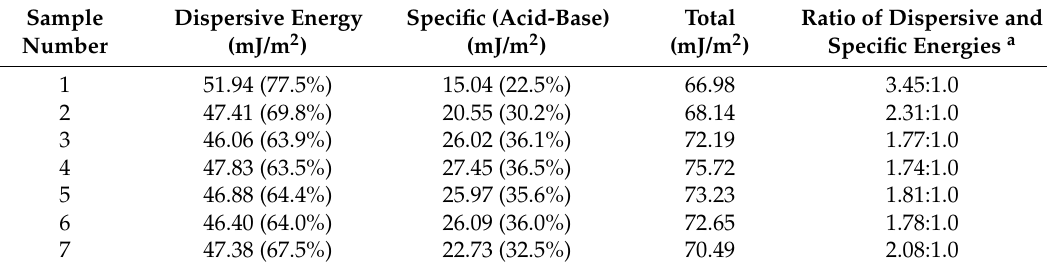
Table 4. IGC results of the produced fibres.